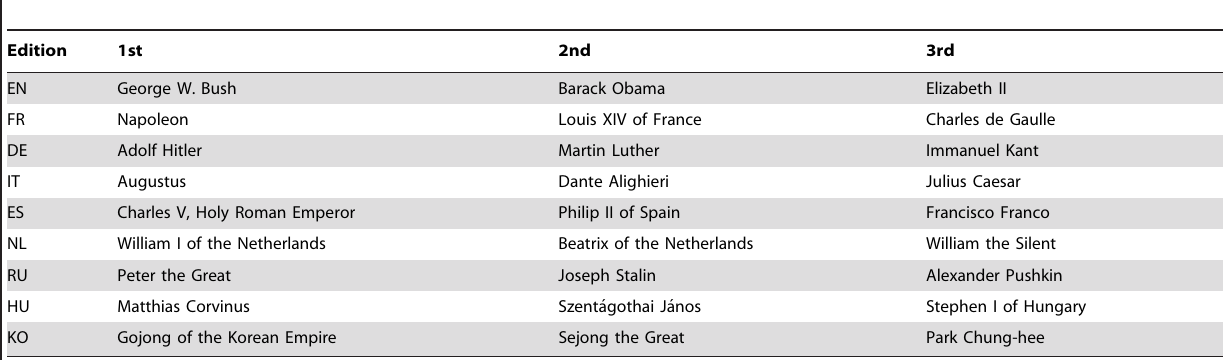
Table 4. List of local heroes by PageRank for each Wikipedia